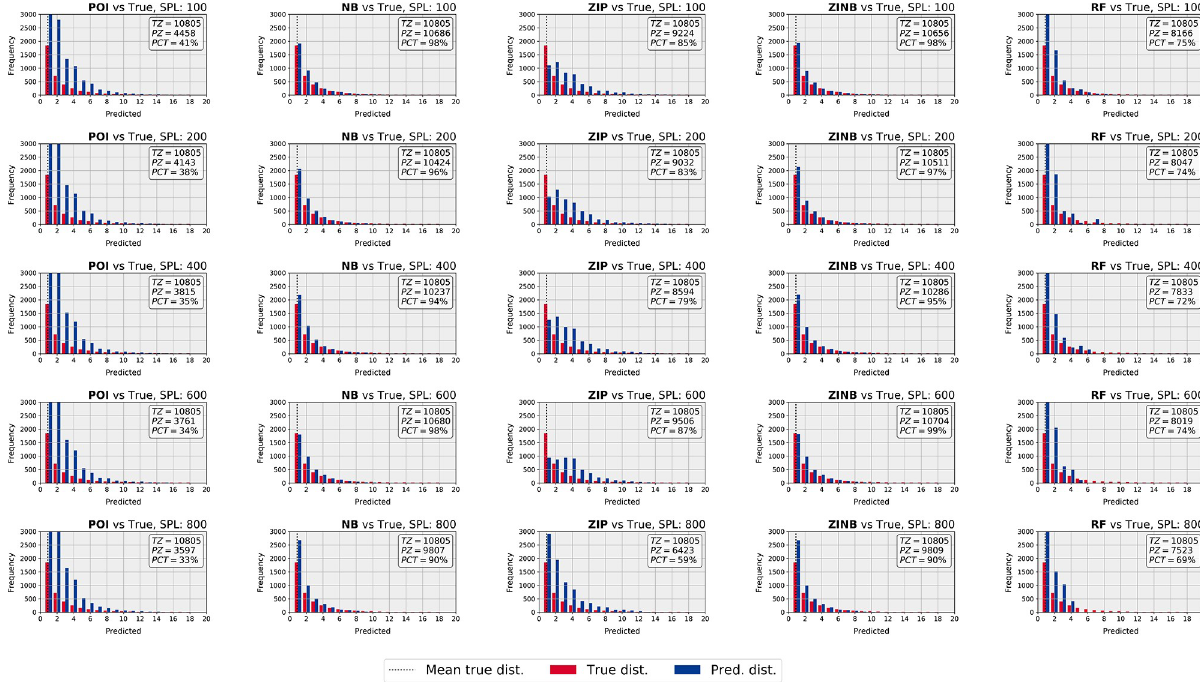
Fig 6. Histograms of original (red) and predicted (blue) distributions for an ensemble with 20 trees and an increasing number of samples per leaf node. Note that for visualization purposes, the axes have been limited and the zeros are summarized in the text box within each subplot, thus showing the number of true zeros, predicted zeros and the associated percentage. The first four columns correspond to the count data models, whereas the last column shows the performance of the canonical RF. As seen, POI and ZIP can predict for a wider range of values, whereas NB and ZINB are good at predicting zeros and the low part of the